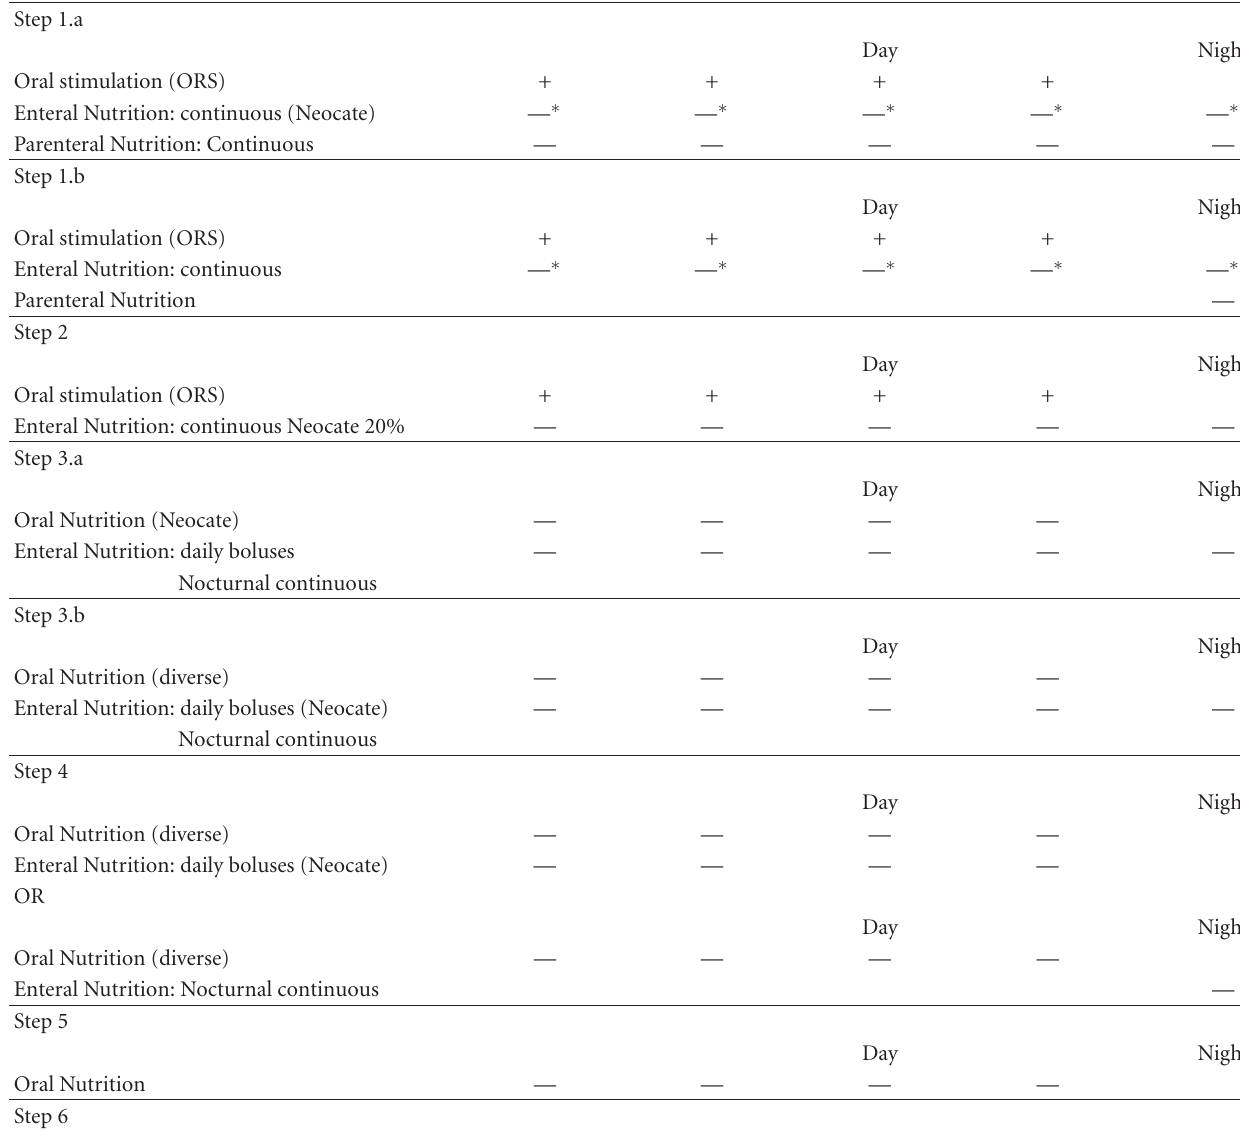
Table 3: EN scheme used and validated in our